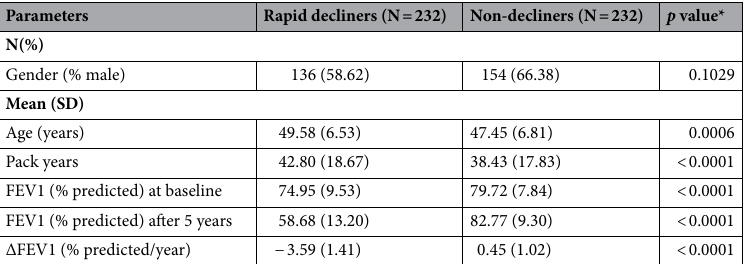
Table 2. Characteristics of the study participants in the rapid and non-decliner groups. *Rapid vs Non- decliners (Fisher’s exact test and two-tailed t test). Statistical analyses were done using the JMP Statistics software package version 13 (SAS Institute Inc.) and R version 3.5.1.